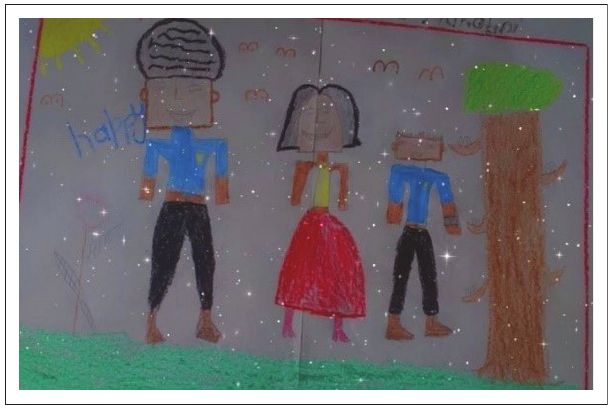
FIGURE 4: Child 4’